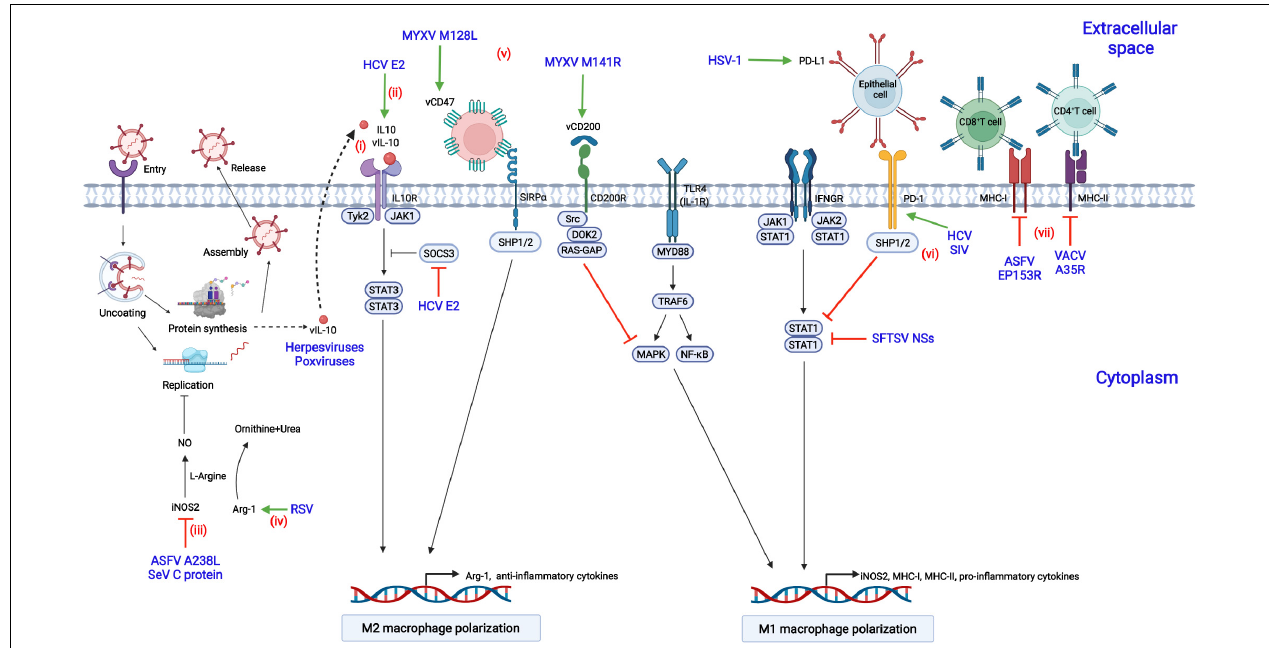
FIGURE 3 | Modulation of macrophage polarization by viral proteins. (i) Herpesviruses or poxviruses encode the homolog of IL-10 (vIL-10), which binds to IL-10R, triggers the activation of STAT3, and contributes to M2 macrophage polarization; (ii) Hepatitis C virus (HCV) encodes the E2 protein, which upregulates IL-10 production by increasing the phosphorylation of STAT3 and reducing the expression of SOCS3; (iii) African swine fever virus (ASFV) infection results in the suppression of nitrogen oxide (NO) production by downregulating inducible nitric oxide synthase 2 (iNOS2) via the A238L protein; (iv) Respiratory syncytial virus (RSV) inhibits NO production by decreasing the expression of arginase 1 (Arg-1) and the level of L-arginine; (v) Myxoma virus (MYXV) encodes the M141R (the viral CD200 homolog) and M128L (the viral CD47 homolog) proteins, which suppress the M1 phenotype polarization of macrophages; (vi) Acute infection with herpes simplex virus type 1 (HSV-1) and chronic infection with HCV or simian immunodeficiency virus (SIV) lead to the increased expression of PD-L1 or PD-1, inhibiting STAT1 activation and M1 macrophage polarization; (vii) The vaccinia virus (VACV) A35R protein suppresses the antiviral responses of T cells by negatively regulating the major histocompatibility complex class II (MHC-II) antigen presentation, while the ASFV EP153R and the HIV-1 Nef proteins downregulate MHC-I